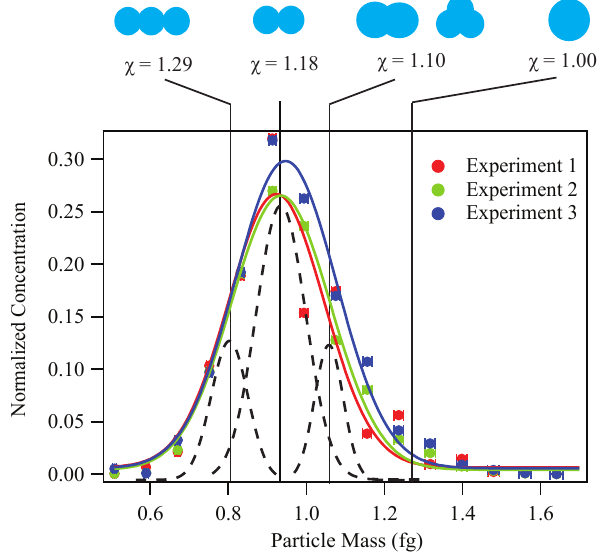
Figure 2. An example of the number–mass distribution, as mea- sured using the DMA-APM system. Results of three replicate ex- periments are shown to demonstrate reproducibility. Two-sigma un- certainty is represented by the error bars, which are approximately the same size as the data markers. The lines represent fits of a nor- mal distribution to the data. The abscissa is calculated based on the APM rotation speed and the voltage applied between the walls of the APM cylinders. Dynamic shape factors calculated by Eq. (1) using m p and d m are indicated by the vertical lines. The particles shown in the plot were produced from 700ppb α -pinene and 14ppm ozone. A central mobility diameter of 126.0nm was selected by the DMA. The width of the DMA-APM instrument train is represented by the dashed